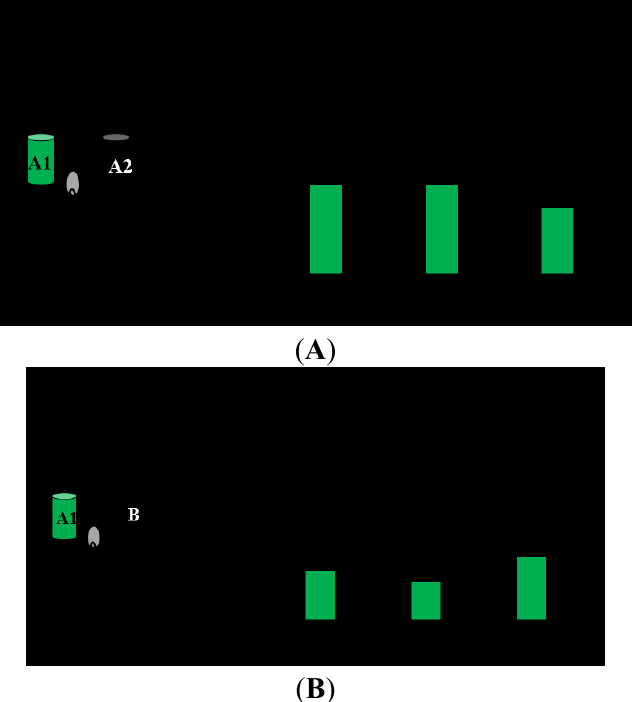
Figure 1. DE-SOA impaired novel object recognition ability after one month exposure. ( A ) Training phase, ( B ) test phase and ( C ) discrimination index in the control, DE and DE-SOA exposed mice. Each bar represents the mean ± SE. A1 and A2 are identical raccoon dog toys and B is bear